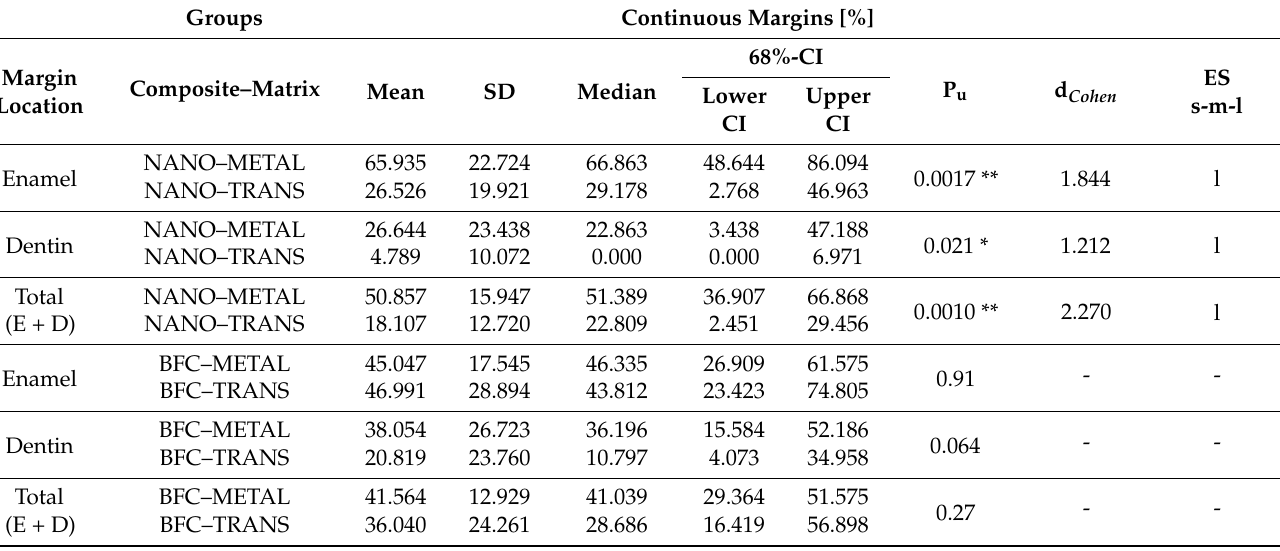
Table 4. Percentage of continuous margins [%] by margin location (enamel or dentin), composite material and matrix type ( n = 10 per